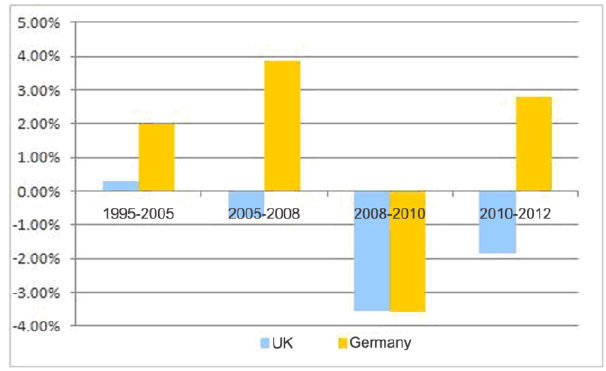
Figure 3. Industry Output, average yearly % change over the following periods: 1995 – 2005, 2005 – 2008, 2008 – 2010, and 2010 – 2012 (data source: Eurostat).